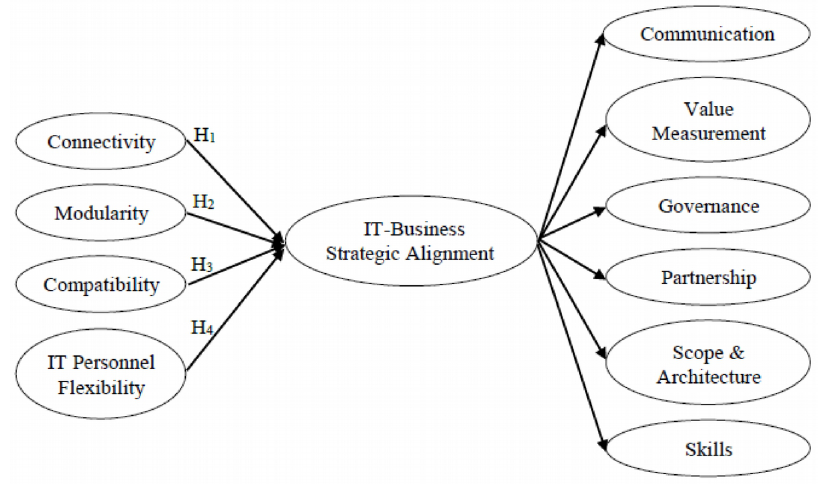
Figure 2. Conceptual